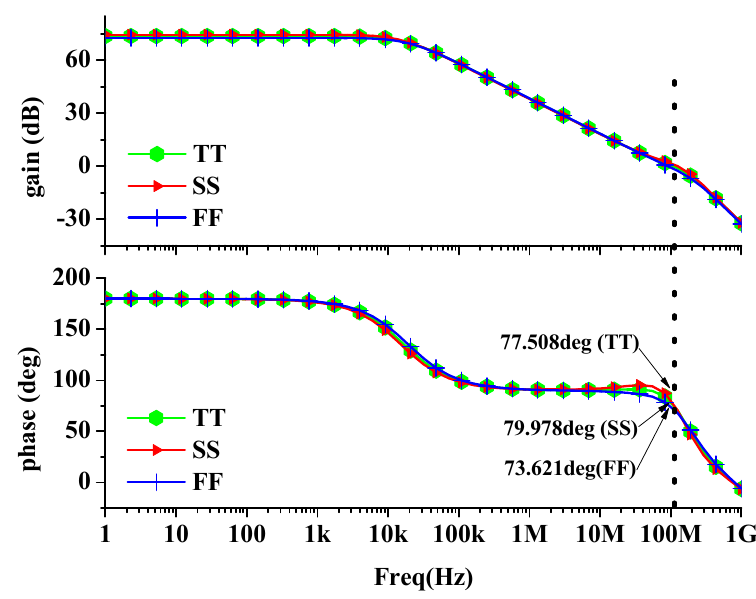
Figure 3. Simulated frequency responses of the OPA under process conditions (TT, SS, and FF).